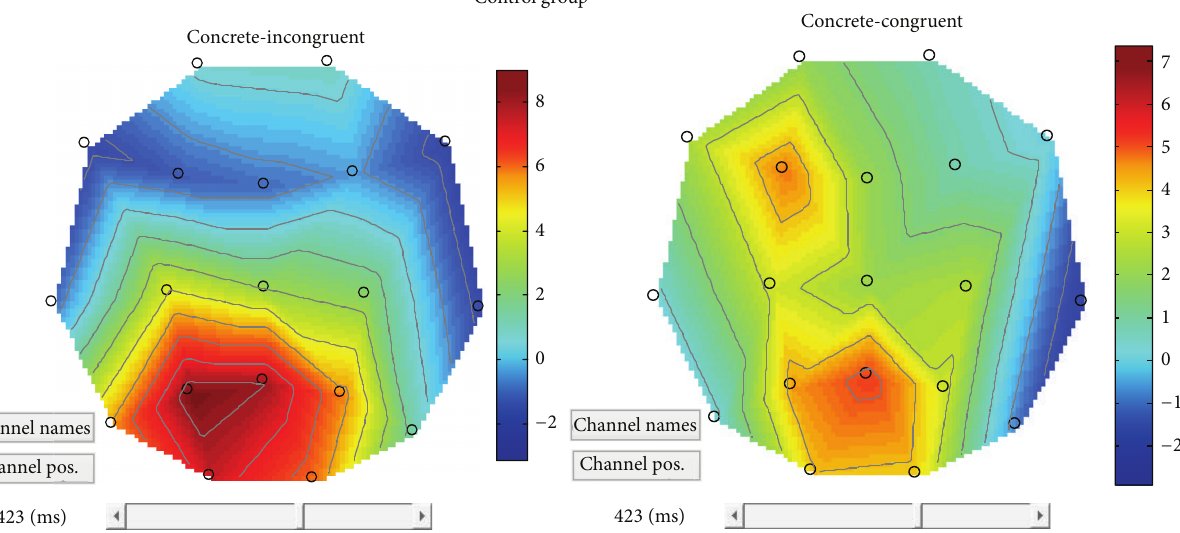
Figure 8: Patterns of brain activation in response to concrete-congruent versus concrete-incongruent stimuli, in the control group.